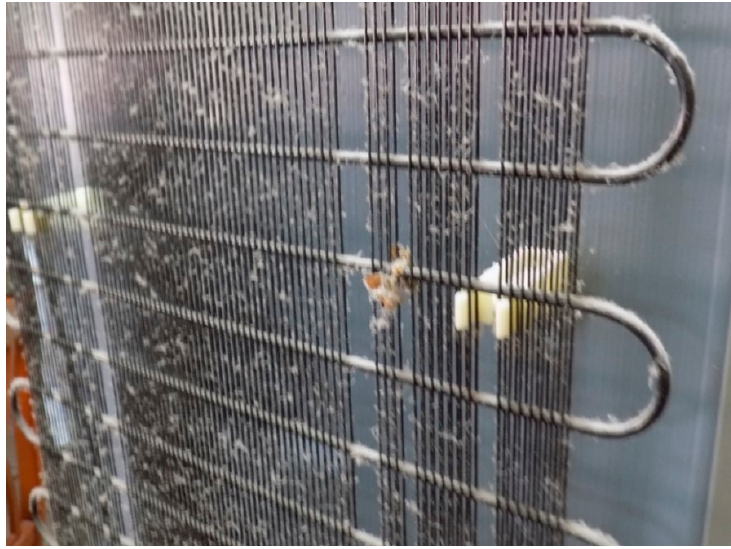
Figure 10. Typical fouling in a condenser.